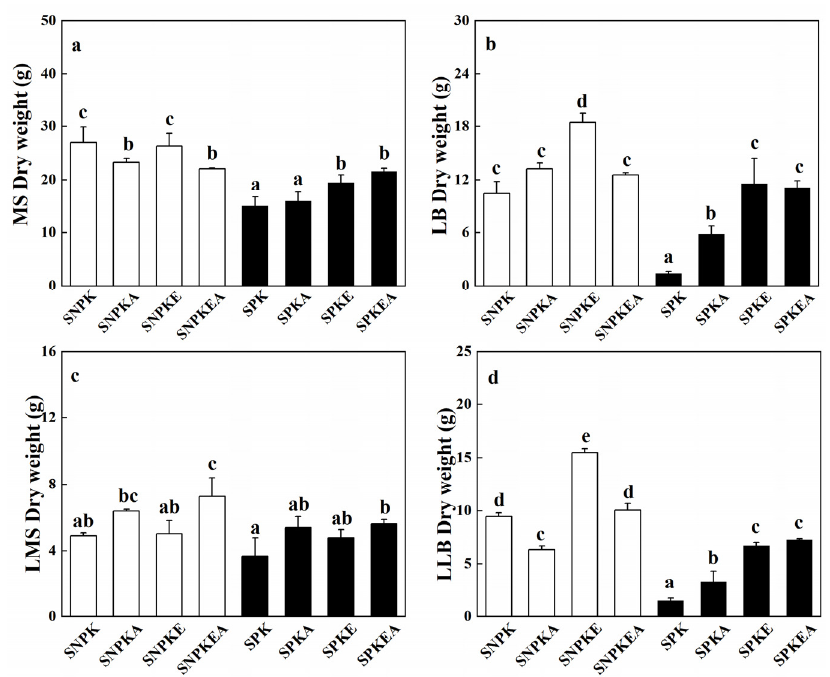
Figure 1. Dry weight of MS (main stem, ( a )), LB (lateral branch, ( b )), LMS (leaf on main stem, ( c )) and LLB (leaf on lateral branch, ( d )) in K. pentacarpos cultivated in non-polluted or polluted soil for five months in the presence or absence of NaCl or/and EDDS. Each value is the mean of 3 replicates and vertical bars are S.E. Values exhibiting different letters are significantly different at p < 0.05 according to SNK test.